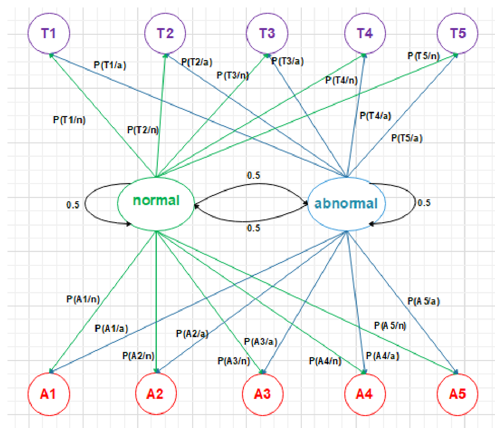
Figure 7. State transition